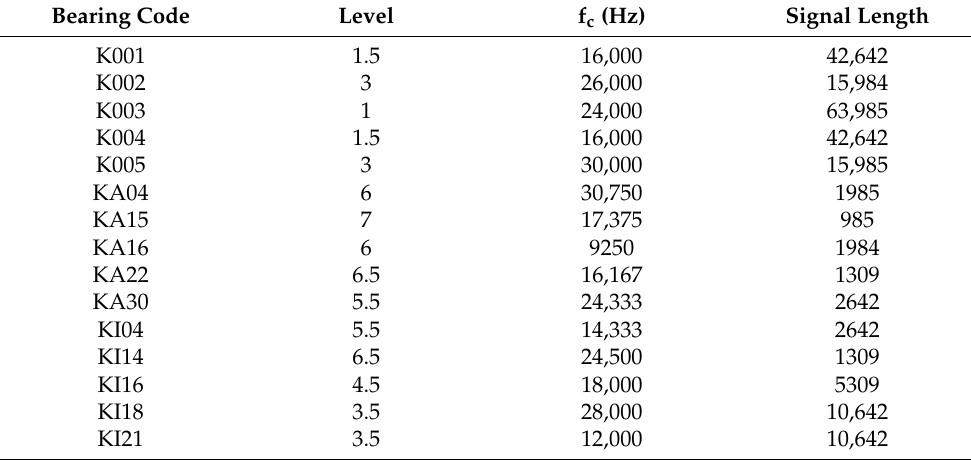
Table 3. Analysis results of